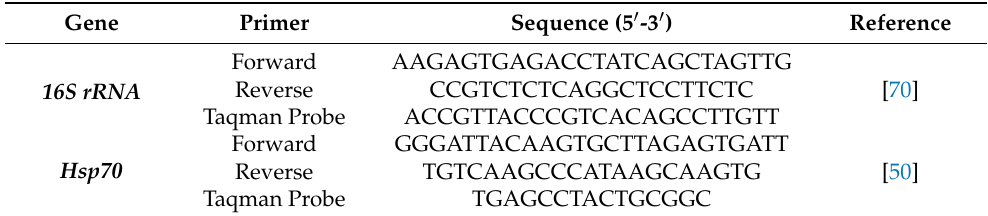
Table 1. Primer sequences used for the qPCR analysis with the Hsp70 and 16S rRNA genes and TaqMan Probes.